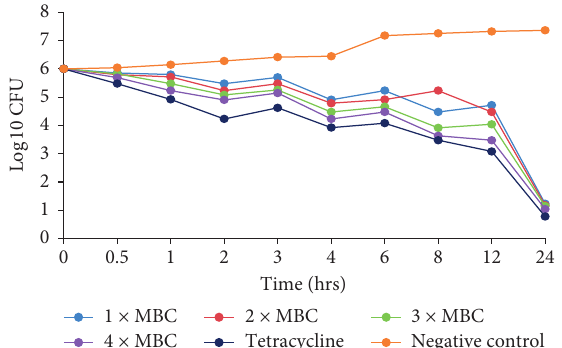
Figure 6: Time-kill kinetics activities of the dichloromethane: methanolic extract of C. asiatica against B. subtilis . Table 3: Phytochemical composition of the dichloromethane: methanolic extract of C. asiatica .